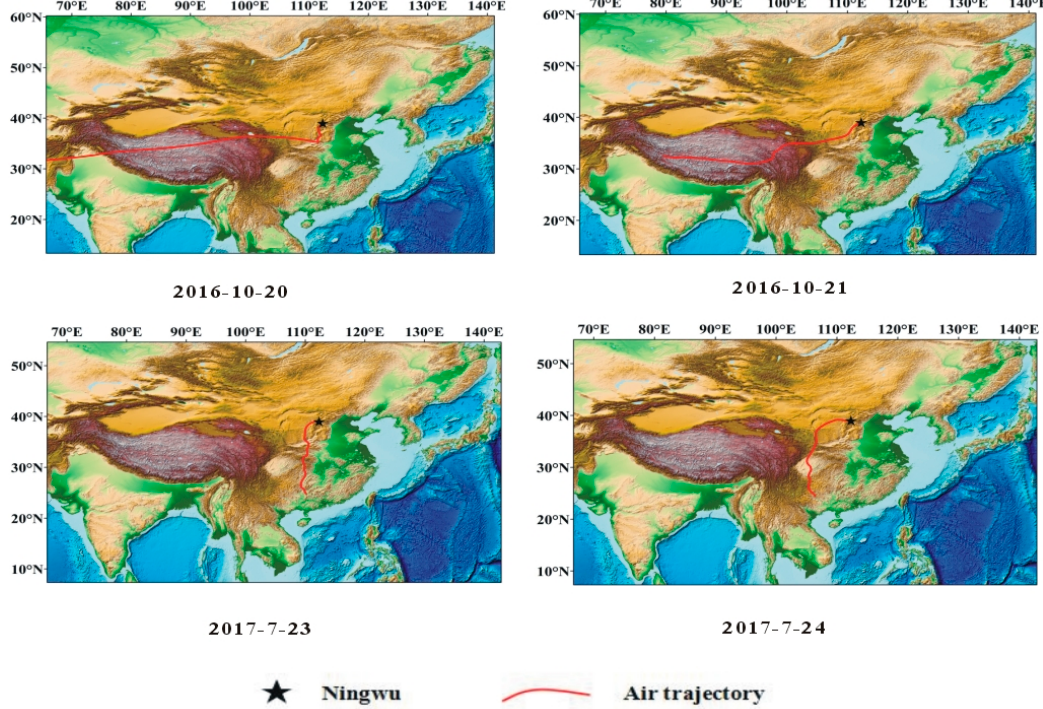
Figure 7. Tracking results for water vapor transport in Ningwu.